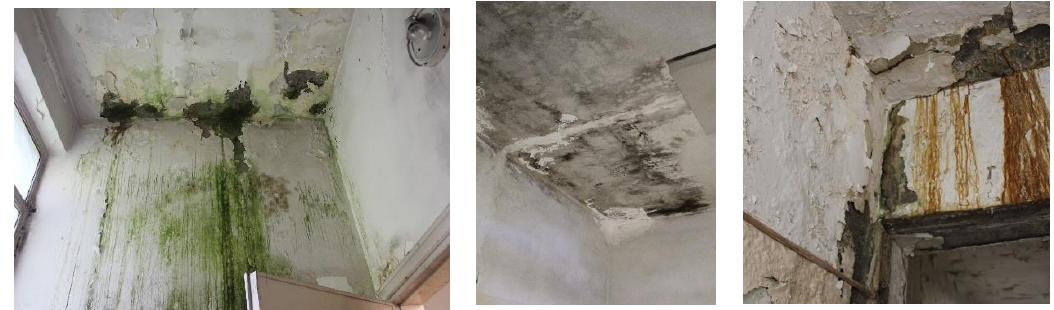
Figure 9. Examples of degradation inside the building.